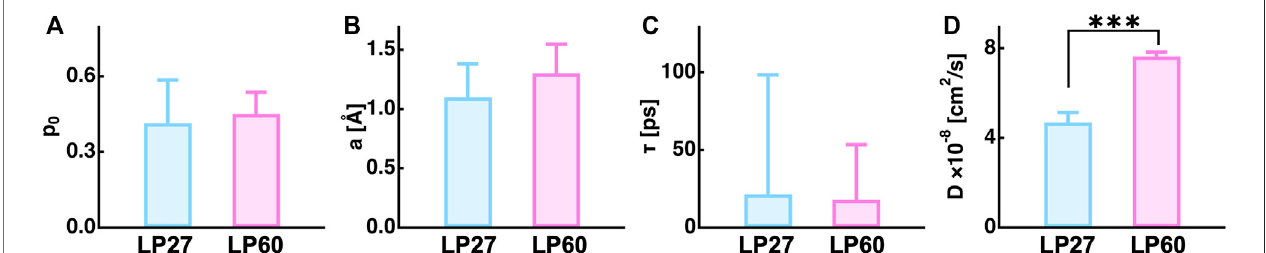
FIGURE 8 | Summary of the dynamics parameters obtained by a global fi tting to the measured QENS spectra. (A) , (B) , (C) , and (D) denote the fraction of the immobile atoms, the amplitude, the residence time, and the jump diffusion coef fi cient of atomic motions. The asterisks (***) show that the difference between the two values are statistically signi fi cant by Student ’ s t -test ( p <